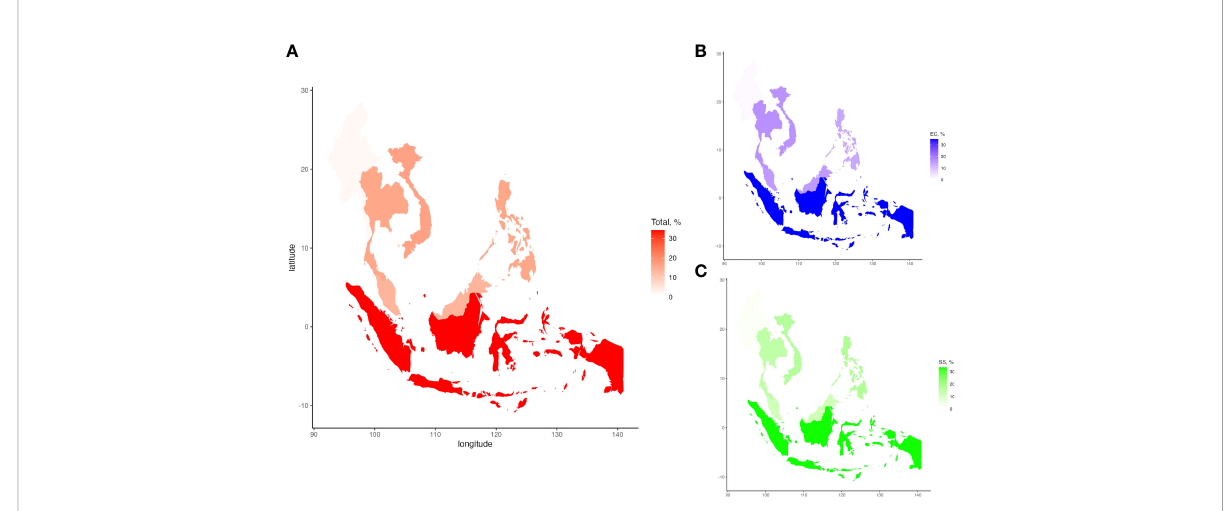
FIGURE 6 Geographical distribution of publications related to mangrove restoration in SE Asia. (A) Total - all document types; (B) . EC, peer-reviewed articles with ecological attributes; (C) . SS, peer-reviewed articles with social attributes